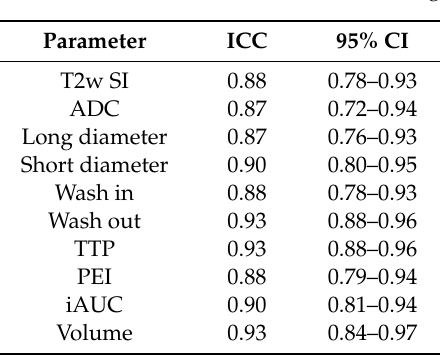
Table 2. Intraclass correlation coe ffi cients (ICCs) of the imaging